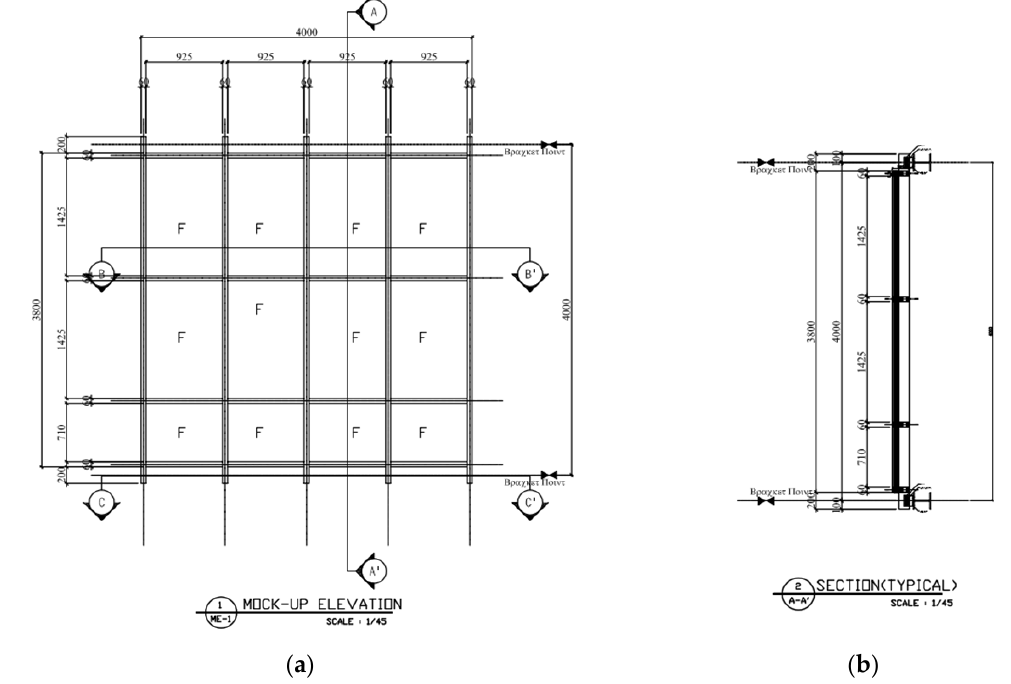
Figure 9. Dynamic seismic test method based on AAMA 501.6.